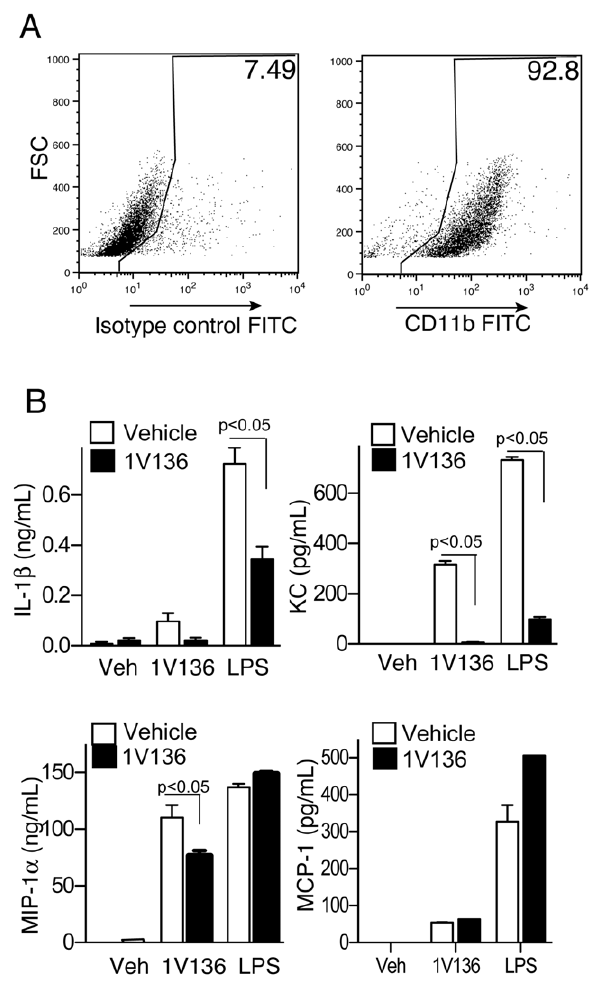
Figure 5. TLR7 ligand treatment induced hyporesponsiveness in primary CNS CD11b-enriched cultures. (A) Mixed glial cells were cultured from the brains neonatal mice and tested for enrichment after 6 weeks by flow cytometry using anti-CD11b antibodies. (B) These primary microglial cultures were treated with vehicle (white bar) or 1 m M 1V136 (black bar) overnight. The cells were then re-stimulated with vehicle (Veh), 1V136 or LPS for 18 h and supernatants were collected. A panel of cytokines and chemokines was analyzed by Luminex microbead assay for IL-1 b , KC, MIP-1 a , and MCP-1. Data shown are mean 6 SEM of triplicates and are representative of three independent experiments. p , 0.05 by Student t test compared to vehicle pretreated